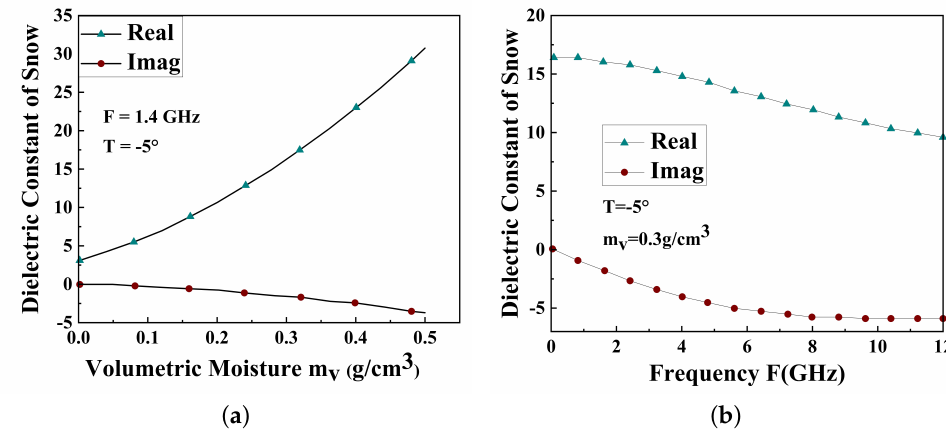
Figure 11. Dielectric permittivity of snow at different volumetric moisture/frequencies. ( a ) Dielectric constant vs. Volumetric moisture. ( b ) Dielectric constant vs.